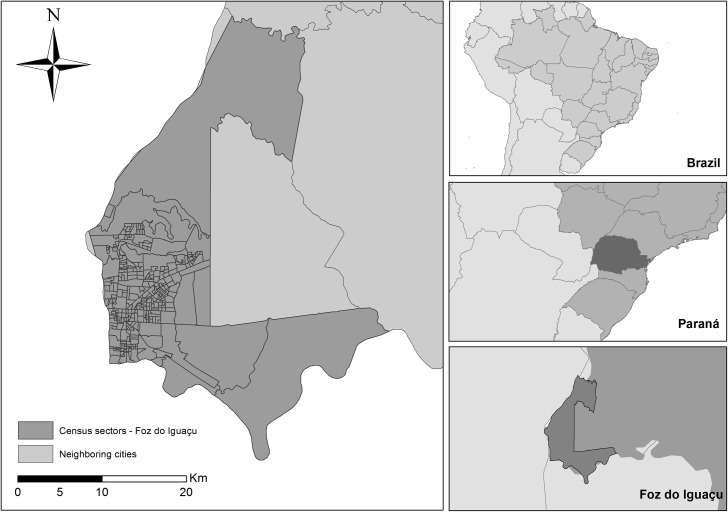
Geographic location of the tri-border region of Brazil, Paraguay and Argentina.